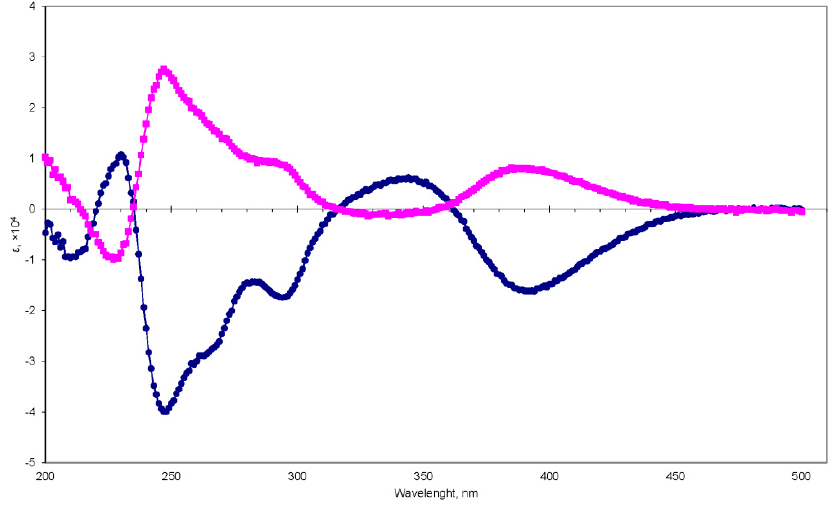
(cid:4) ) and 1b (blue, (cid:8)